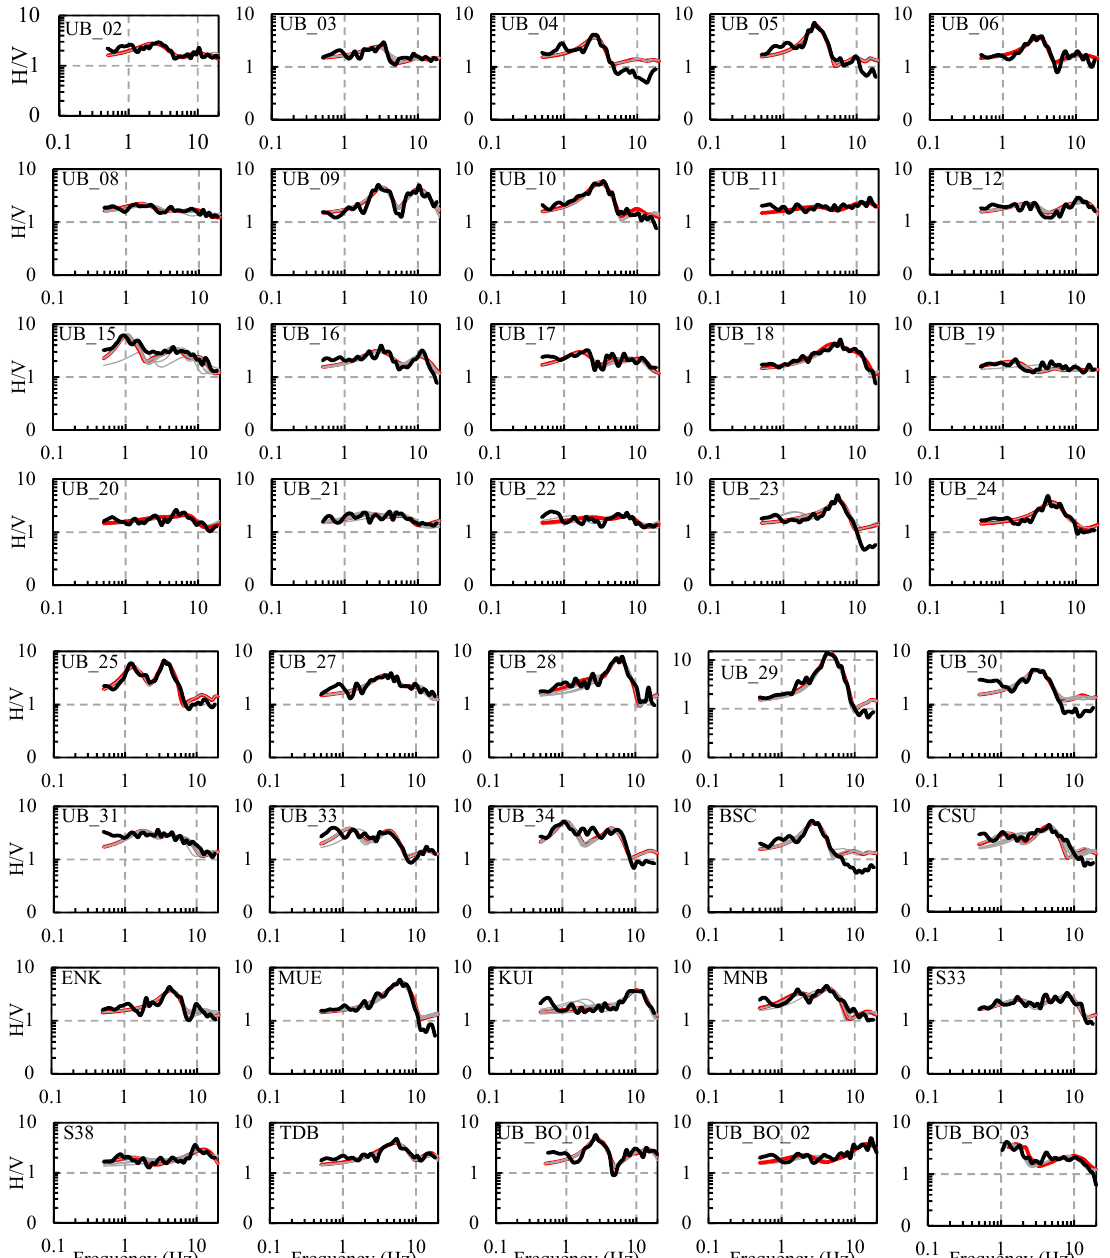
Figure 5. Observed and theoretical MHVRs obtained by single inversion; the black line indicates observed MHVR; the red line indicates inverted best MHVR; the gray lines indicate inverted models.